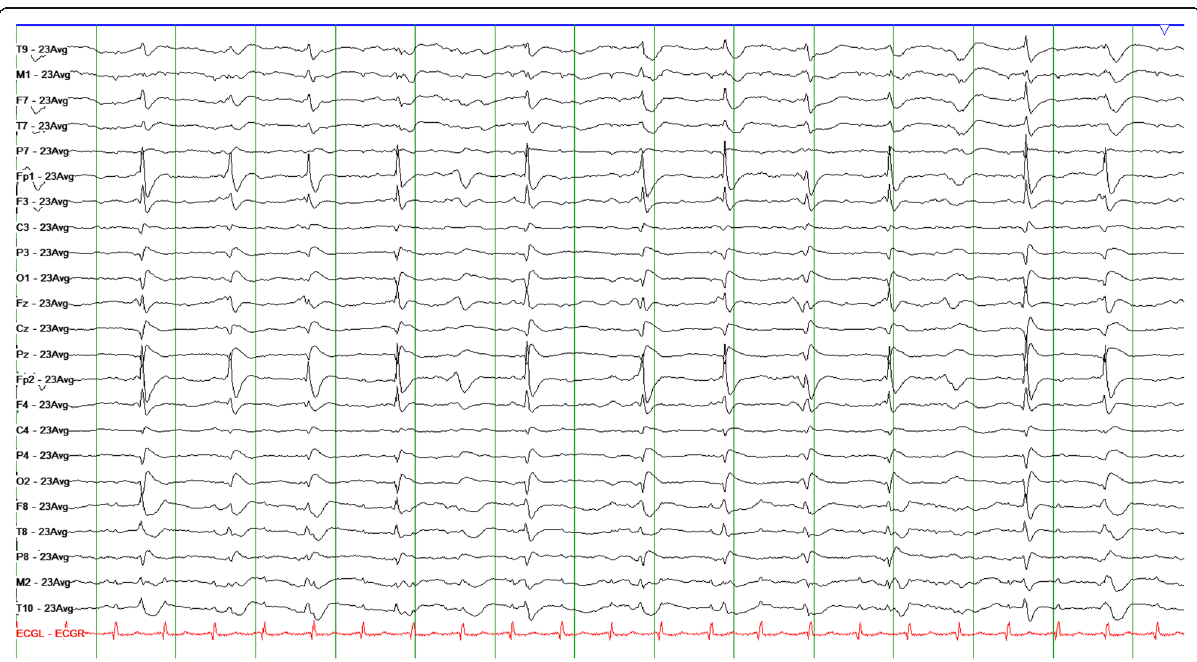
Fig. 2 Generalized periodic discharges (GPDs) at a frequency of approximately 1 Hz in a patient with anoxic brain injury. High pass filter 1Hz, low pass filter 50 Hz and sensitivity 10